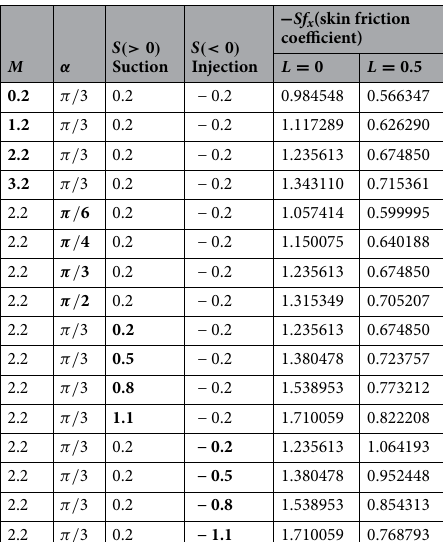
0.5 ) and without slip ( L 0 ) conditions. The varying = =